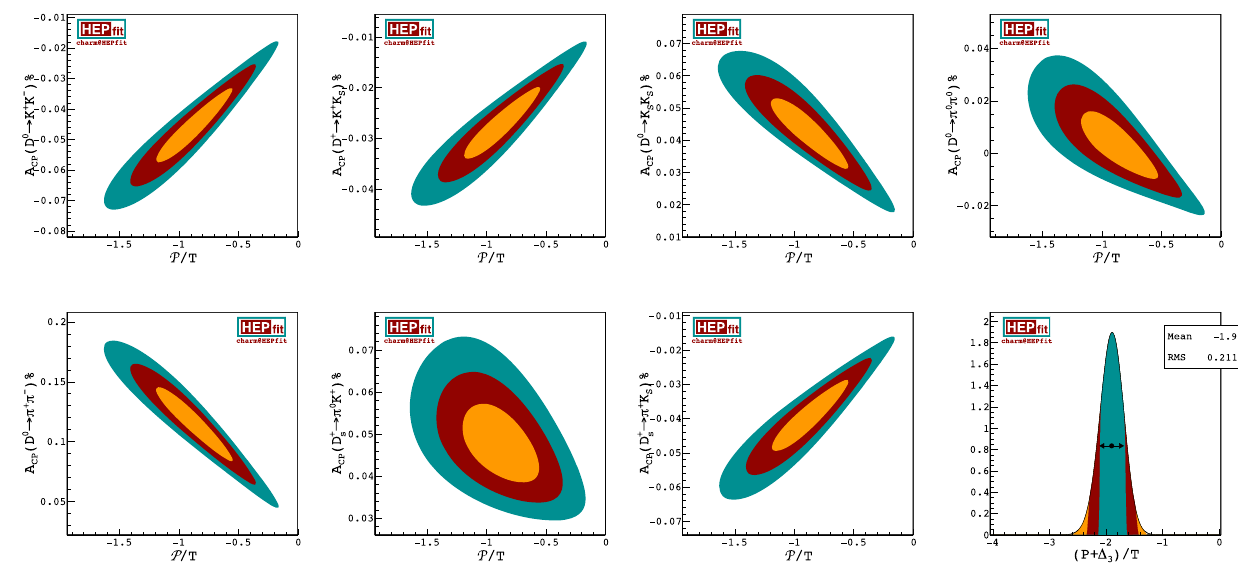
tively. The bottom right-most panel shows the fit to ( P + (cid:5) 3 )/ T = P / T − 1. The orange, red and green regions are the 68%, 95% and 99% probability regions respectively for the 2D histograms and the contrary for the 1D histogram. More details can be found in Ref.